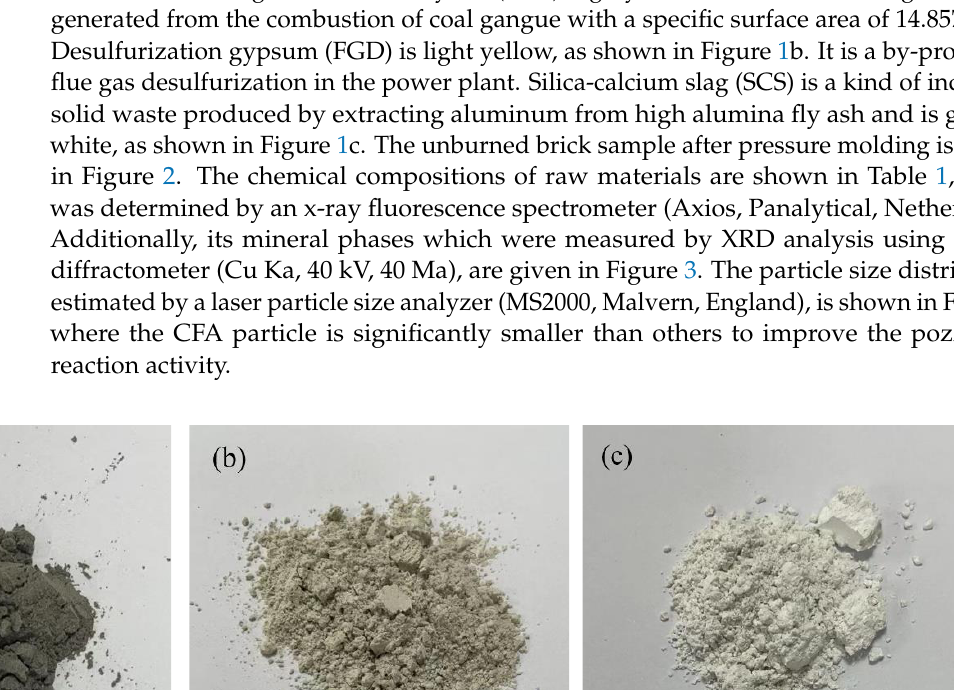
Table 1. Chemical compositions of raw materials (wt.%).